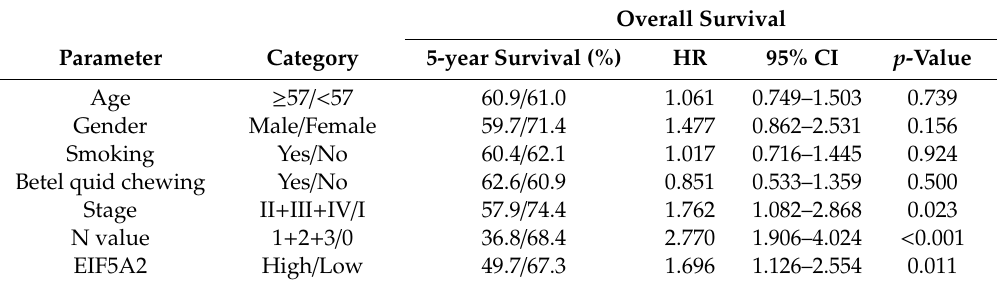
Table 3. Univariate analysis of the influence of various parameters on the overall survival of oral cancer patients.